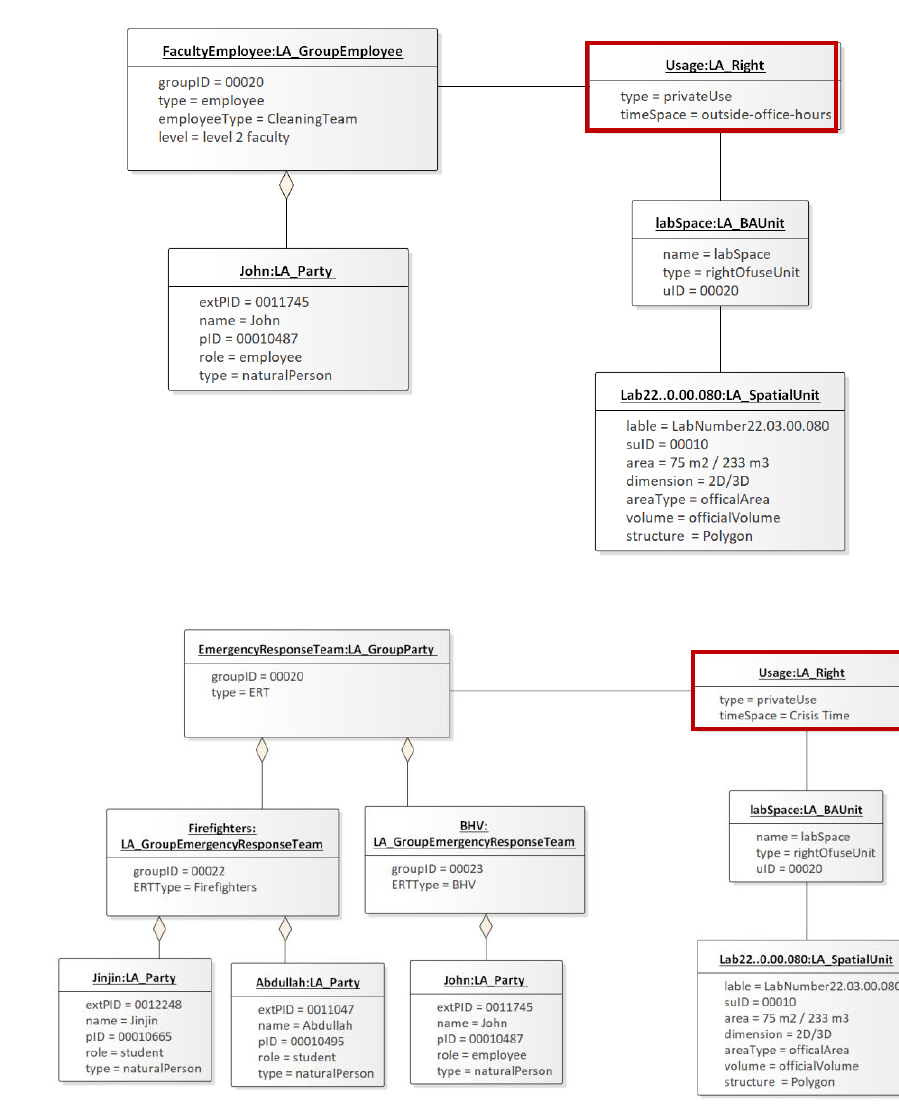
Figure 4. shows different timeSpace conditions for the same access